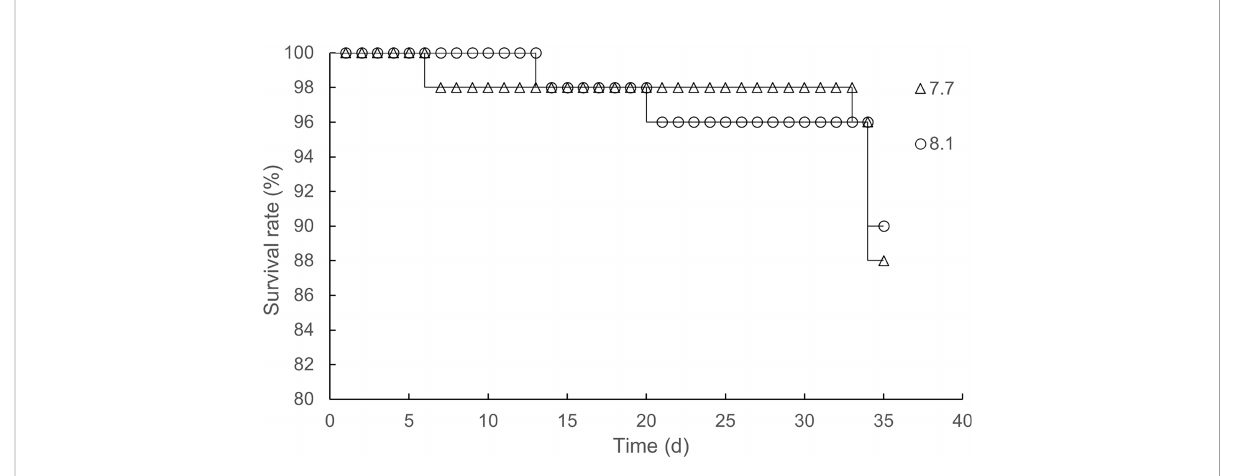
FIGURE 3 Time-survival rate relationship under pH 7.7 and pH 8.1